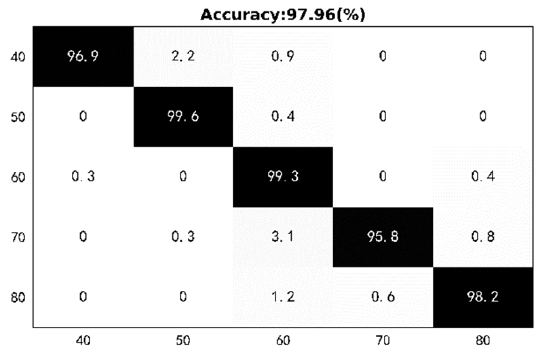
Figure 12. Confusion matrix of out-of-sync distances test.